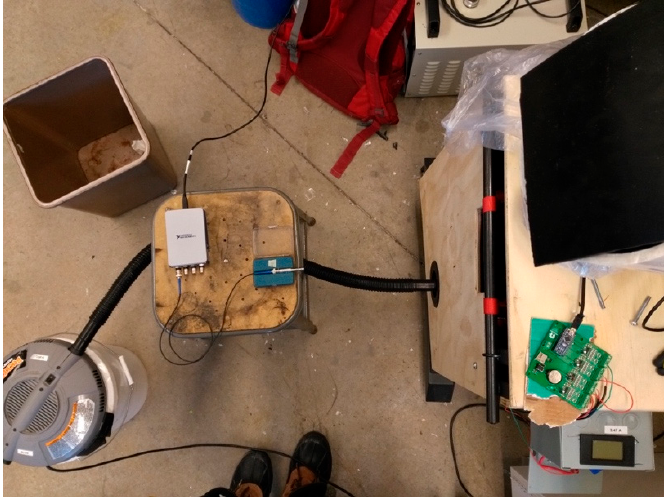
Figure 7. Sound measurement test setup depicting the microphone in one of the test locations.